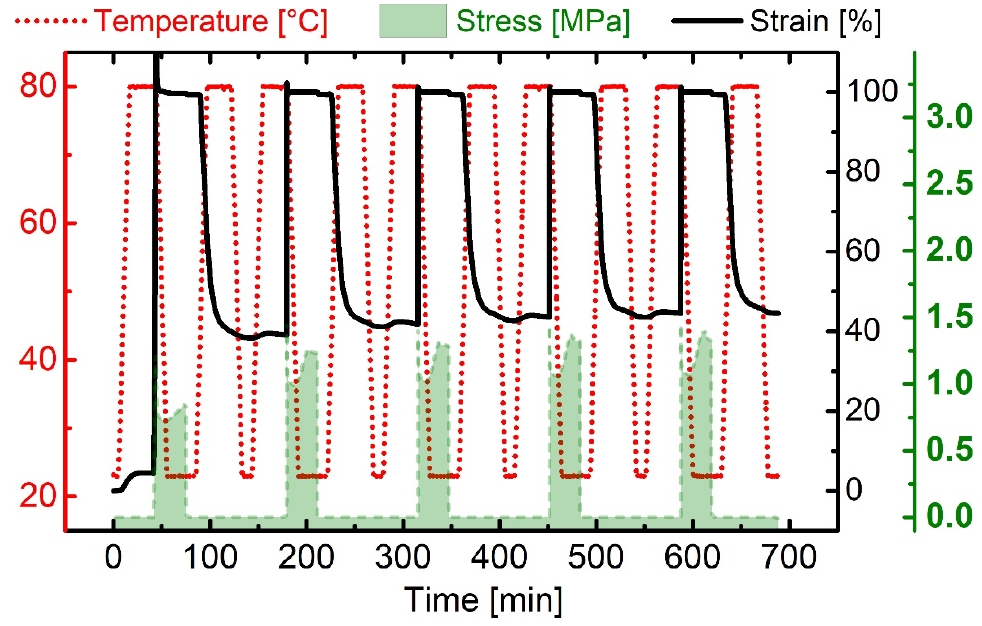
Figure 2. Cyclic DMA measurement protocol for PPG-based TPU. The individual parameters in- cluded T high = 80 °C, T low = 23 °C, and ε max = 100%. The evolution of temperature (red dotted), stress (green area), and strain (black line) were recorded for five cycles.